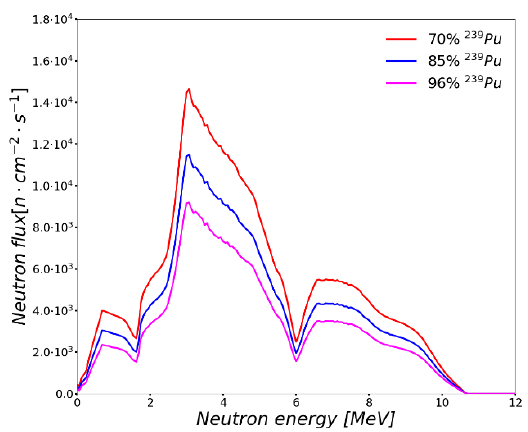
Fig. 8 – 239 PuBe neutron spectra depending on the 239 Pu content calculated with iSourceC